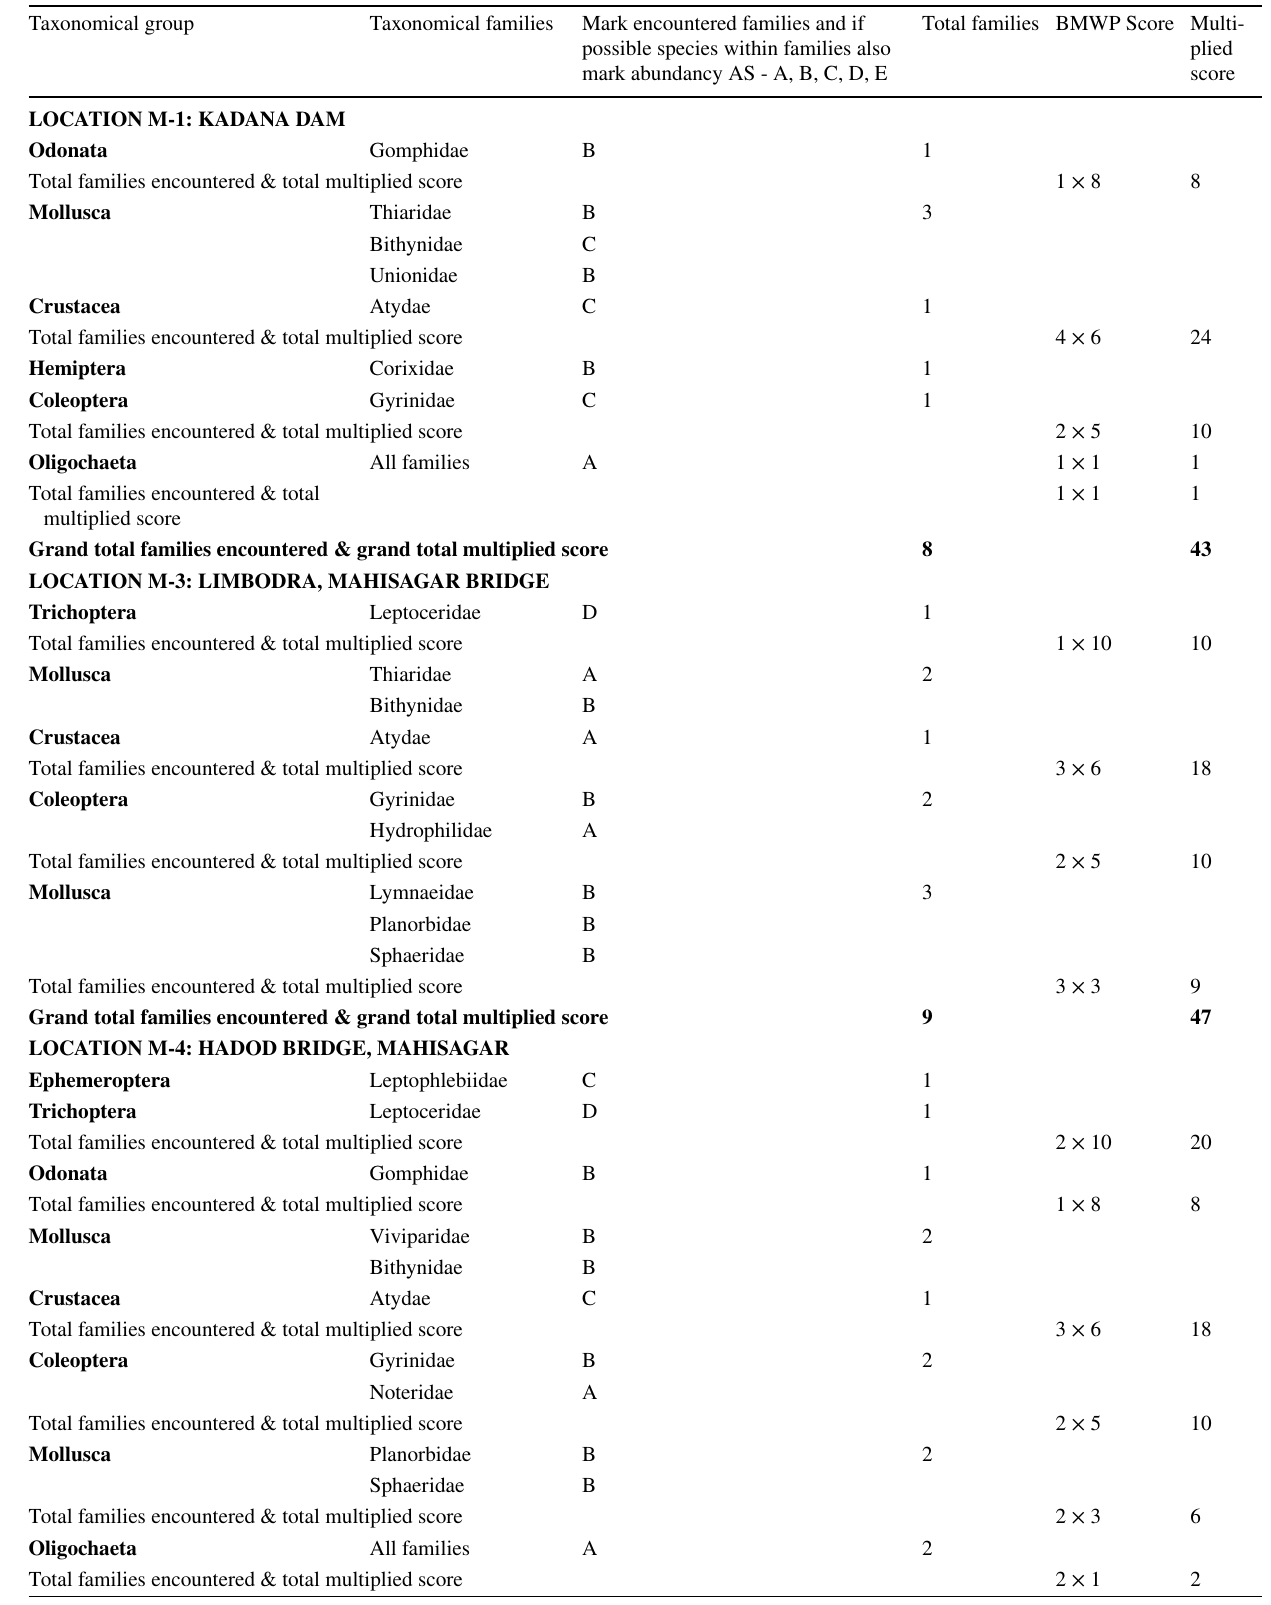
Table 4 Locationwise calculation of Saprobic Score Taxonomical group Taxonomical families Mark encountered families and if